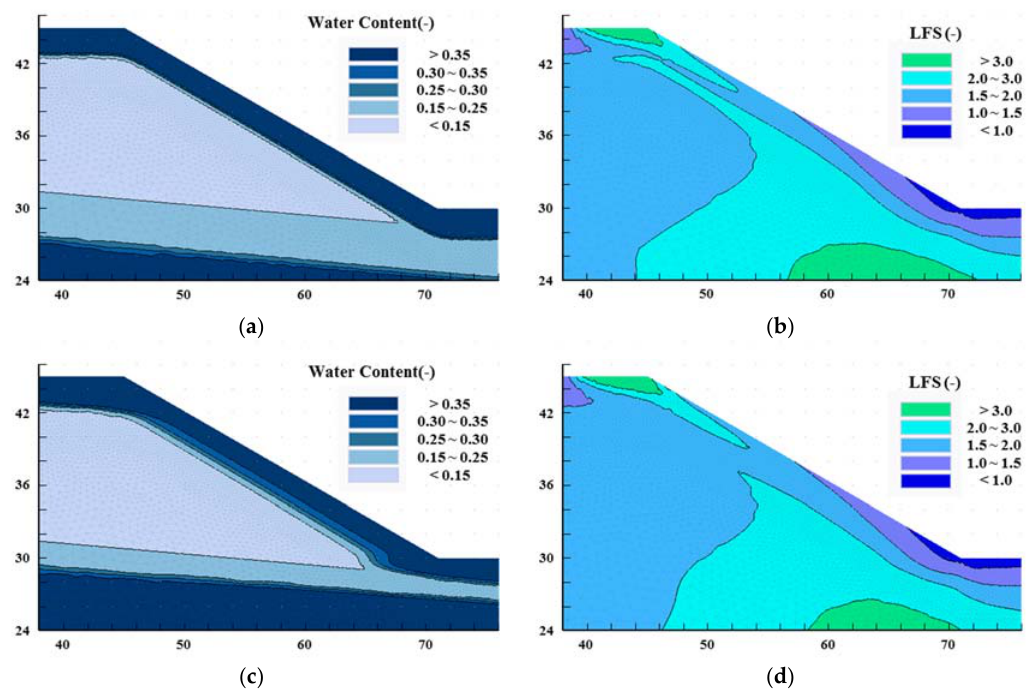
Figure 4. Effect of soil hydraulic conductivity anisotropy on soil water content and local factor of safety (LFS) distribution (using results for loam slope as an example). ( a ) K r = 1 (water content); ( b ) K r = 1 (LFS); ( c ) K r = 100 (water content); ( d ) K r = 100 (LFS).